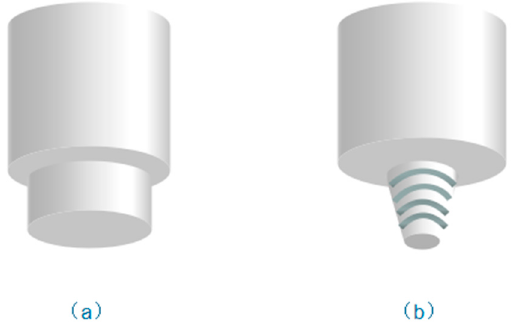
Figure 2. Two common kinds of stir tools: ( a ) pin-less and ( b ) with pin.